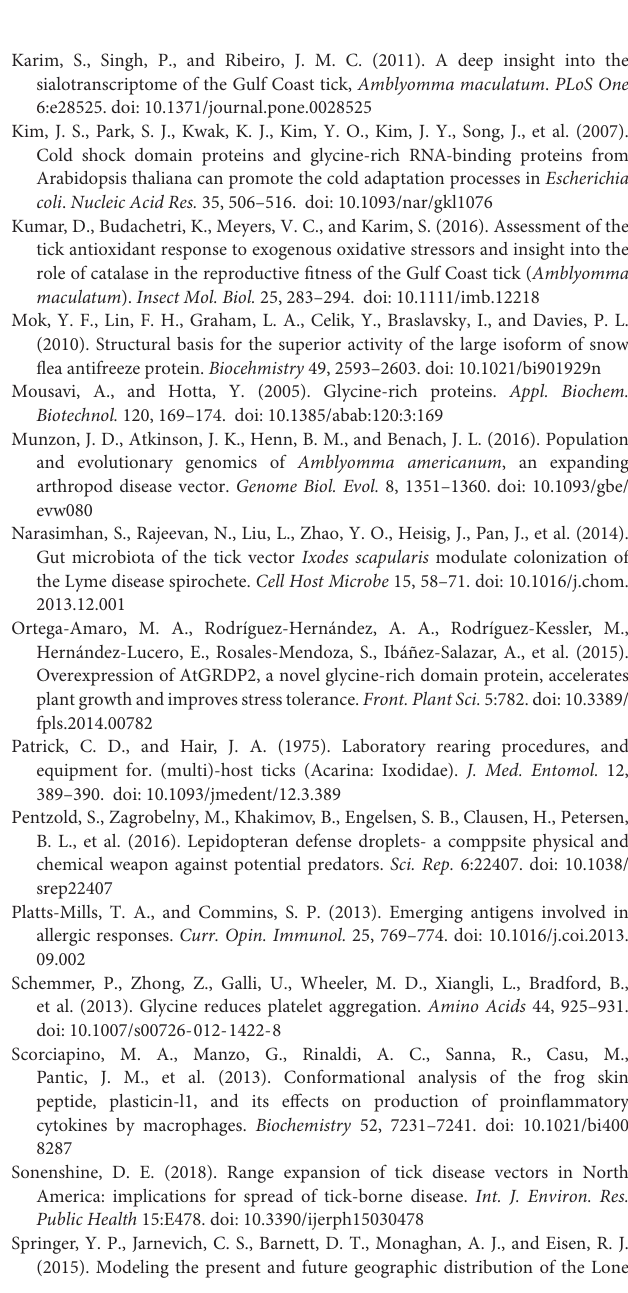
FIGURE S1 | Experimental design to examine the transcriptional expression of glycine-rich proteins at organismal and tissue level after stress exposure. FIGURE S2 | Multiple sequence alignment of selected glycine-rich proteins. Sequences are highlighted based on amino acid property and conservation. TABLE S1 | List of primers used in this